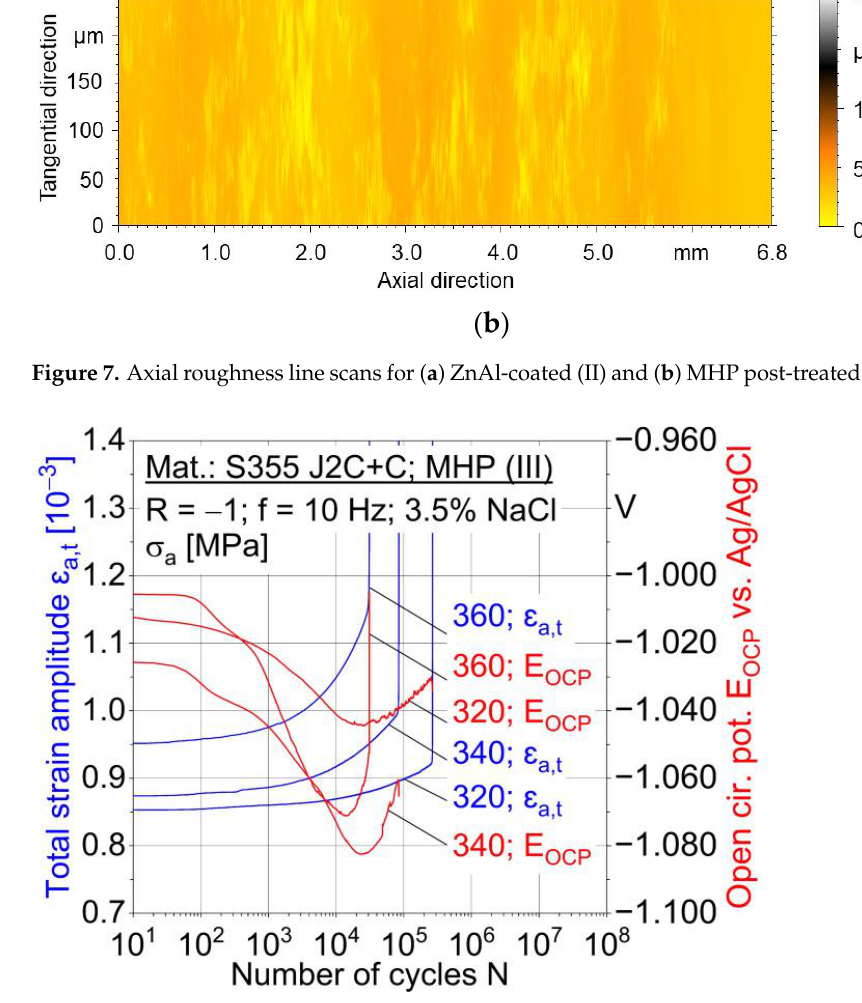
Figure 7. Axial roughness line scans for ( a ) ZnAl-coated (II) and ( b ) MHP post-treated (III) speci- mens.